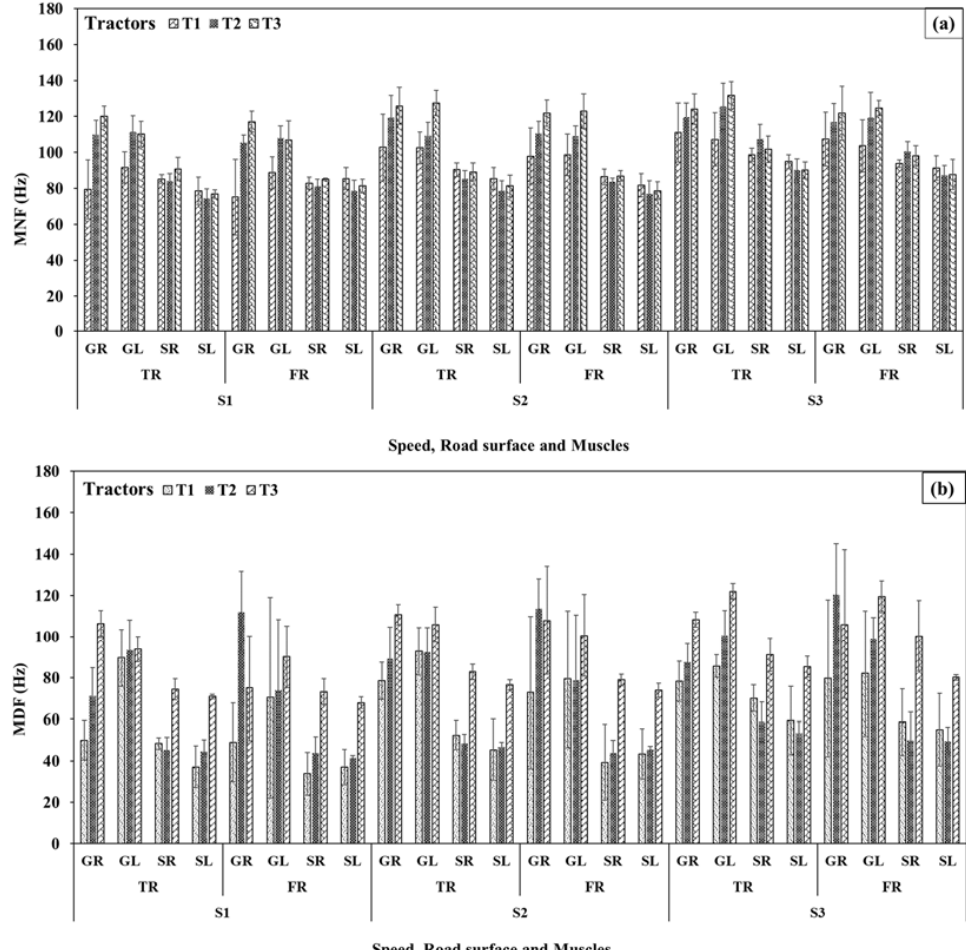
Figure 9. Electromyography ( a ) mean, and ( b ) median frequencies of evaluated muscles during tractor brakes and clutch operations. TR—Tarmacadam road surface, FR—Farm road surface; C—Clutch, B—Brakes. Further details are presented in Table 3.